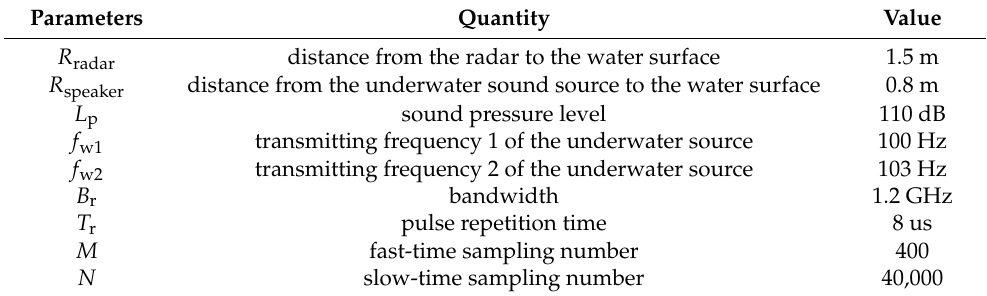
Table 1. Simulation